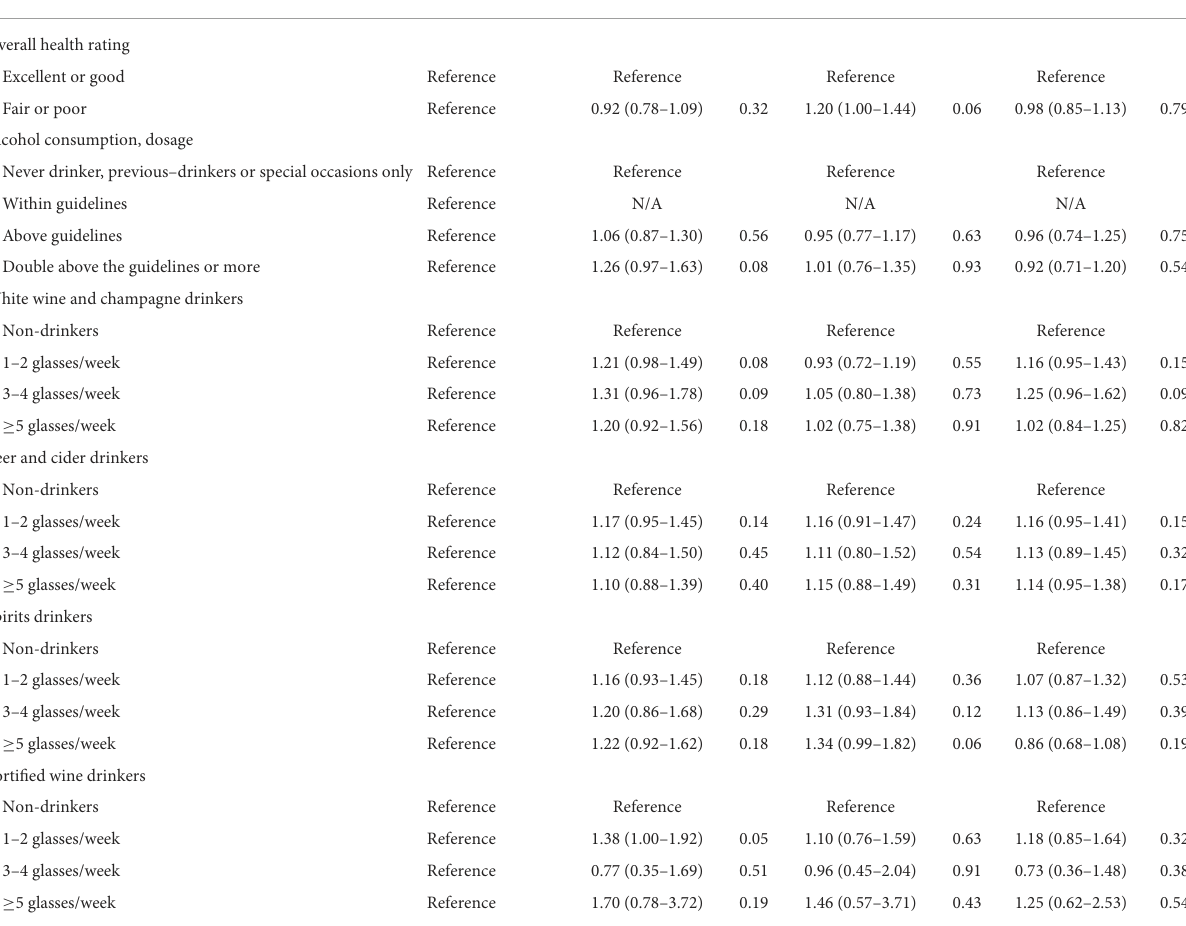
TABLE 7 Odds ratios and 95% CIs for the interaction effect between red wine and risk of